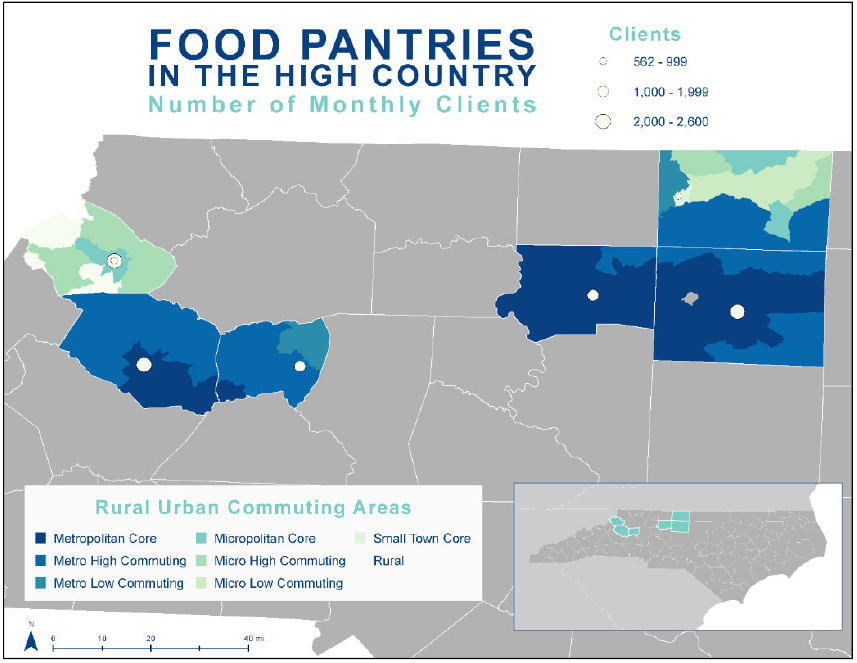
Figure 1. Pilot Study GIS Mapping Example: Rural and Urban Continuum Codes and the Number of Monthly Clients at Each Food